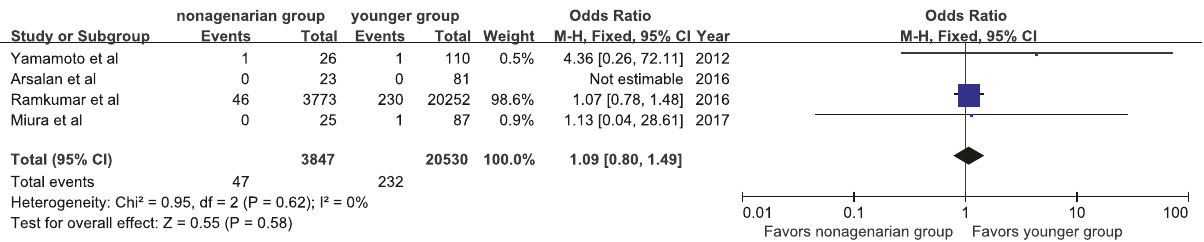
Figure 9: Forest plot of pooled analysis comparing the rates of myocardial infarction in nonagenarians versus younger patients.